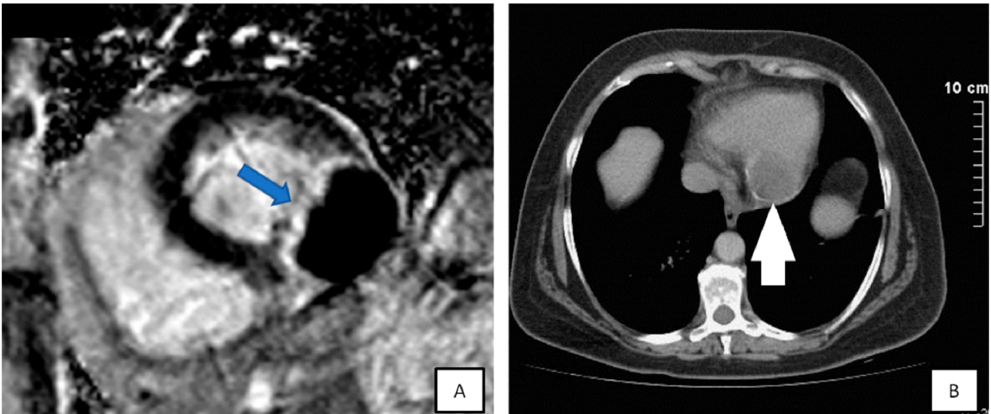
Figure 9. ( A ) Short-axis of late-gadolinium enhancement image demonstrating the echinococcus cyst attached to inferolateral wall, highly hypointense with hyperintense border (blue arrow). ( B ) CT demonstrated a calcified cyst (white arrow) proved to be a cardiac echinococcus cyst.